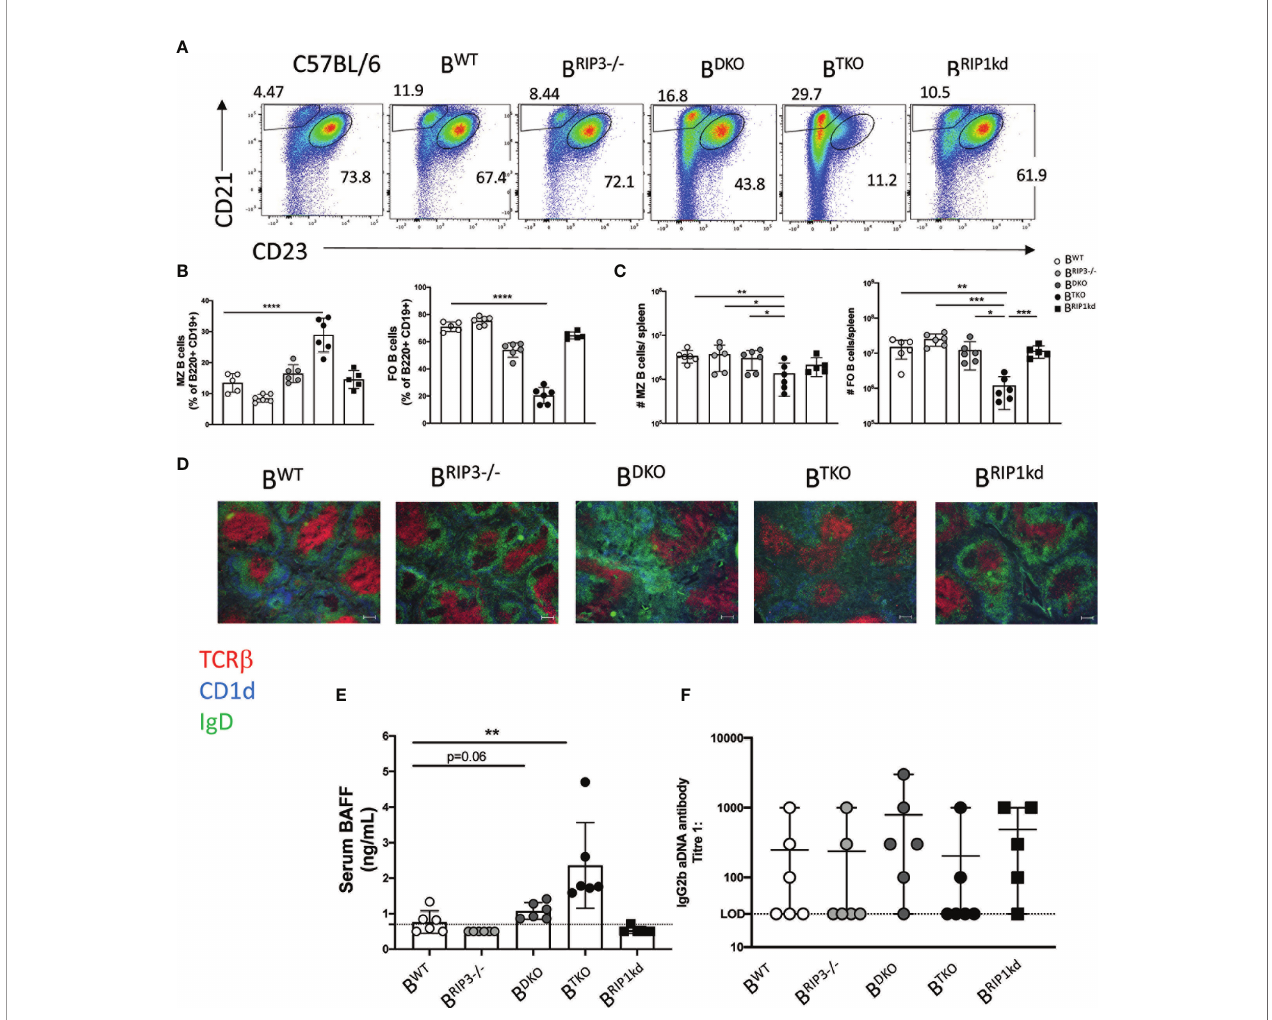
FIGURE 4 | Intrinsic RIP1 and caspase-8 is required for innate MZ B cell homeostasis. Flow cytometry reveals frequency of CD45.2 + B220 + CD19 + B cells that are MZ B cells (CD21 hi CD23 lo ) vs FO B cells (CD21 lo CD23 hi ) in spleens from B WT , B RIP3-/- , B DKO , B TKO and B RIP1kd mixed bone marrow chimeras 10 weeks post reconstitution (A) , quanti fi ed in (B) . Donor MZ B cells and FO B cells numbers per spleen are shown in (C) . Immuno fl uorescent images of 6 m m thick spleen sections from mice in (A) labeled to identify T cell zone (anti-TCR b ; red), B cell zone (anti-IgD; green), and Marginal zone (anti-CD1d; blue) (D) . ELISA detected serum BAFF from B WT , B RIP3-/- , B DKO , B TKO and B RIP1kd mice 10 weeks post reconstitution (E) . ELISA detected IgG2b serum autoantibody titers in B WT , B RIP3-/- , B DKO , B TKO and B RIP1kd mice (F) . Data is representative (A, D) or a pool (B, C, E, F) of two- three independent experiments, 2-4 mice per group. Each symbol indicates an individual mouse. *p ≤ 0.05, **p ≤ 0.01, ***p ≤ 0.001, ****p ≤ 0.0001 (One-way ANOVA and Non-parametric Unpaired two-tailed t-test). Scale bar=100 m